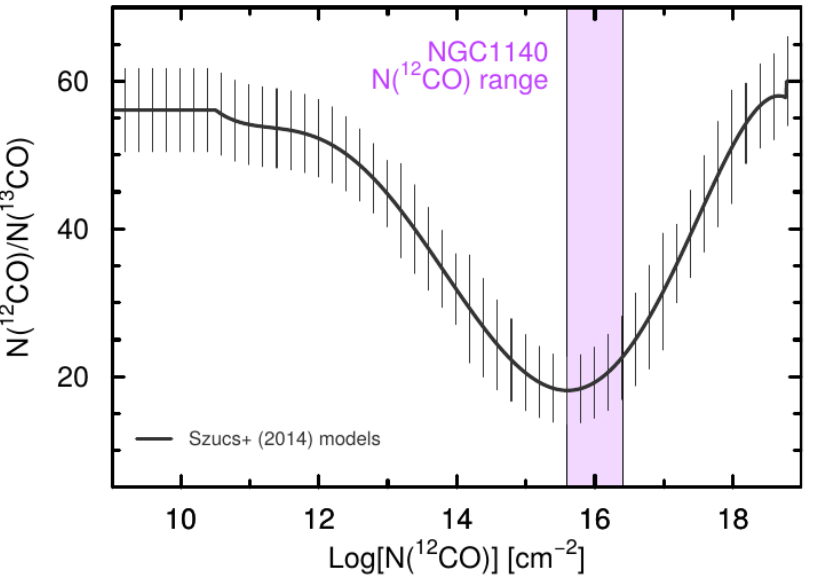
Figure 10. The carbon isotope ratio 12 C/ 13 C as traced by CO is plotted against the CO column density. The degree of fractionation follows the models of [190]; taken from